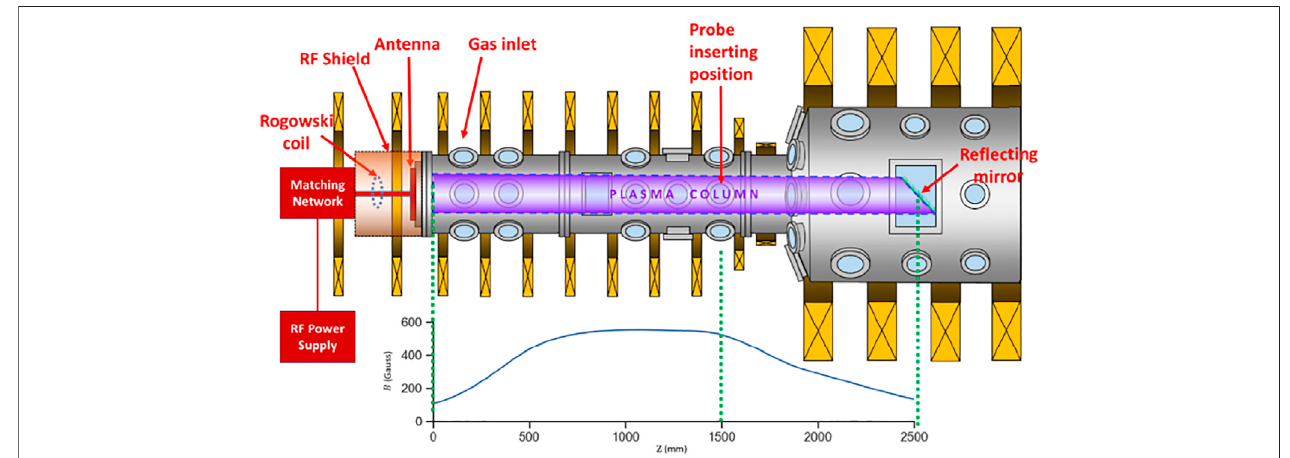
FIGURE 7 | LEAD (linear experimental advanced device). Reproduced from [43], with the permission of IOP